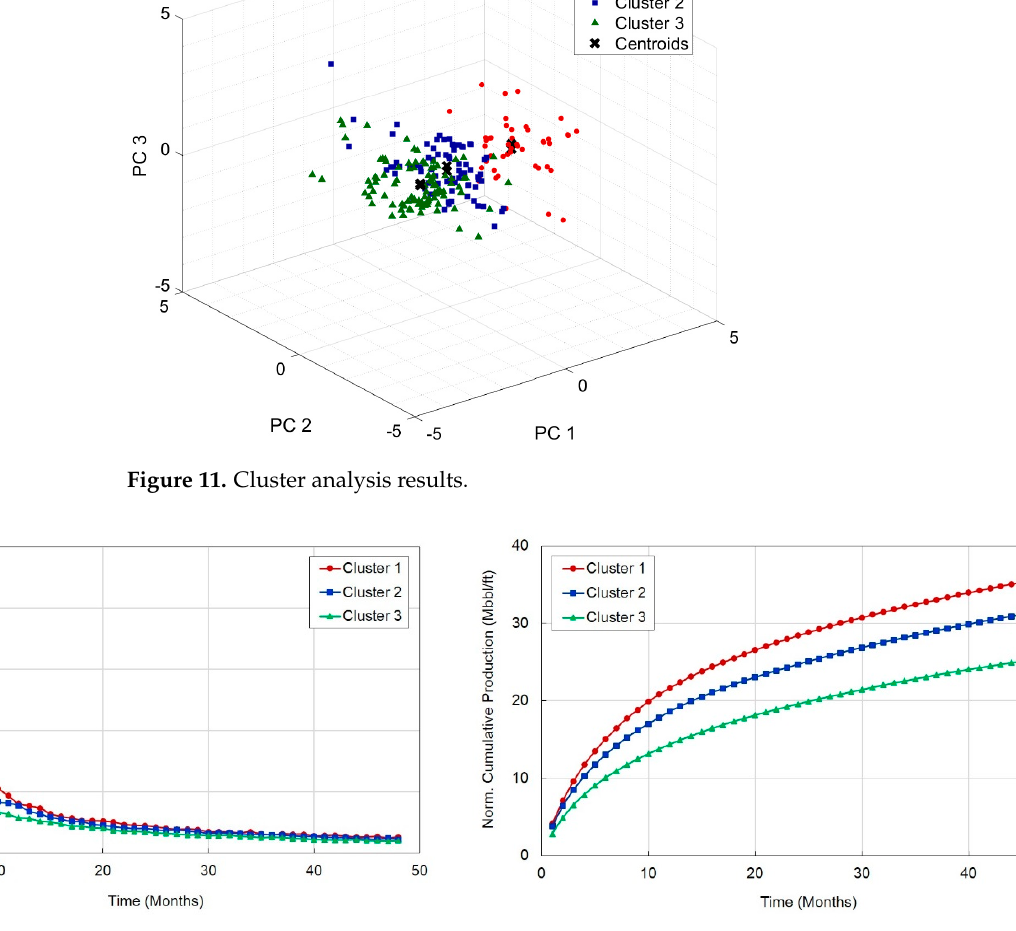
Figure 11. Cluster analysis results.